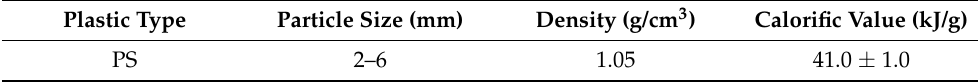
Table 1. Polystyrene